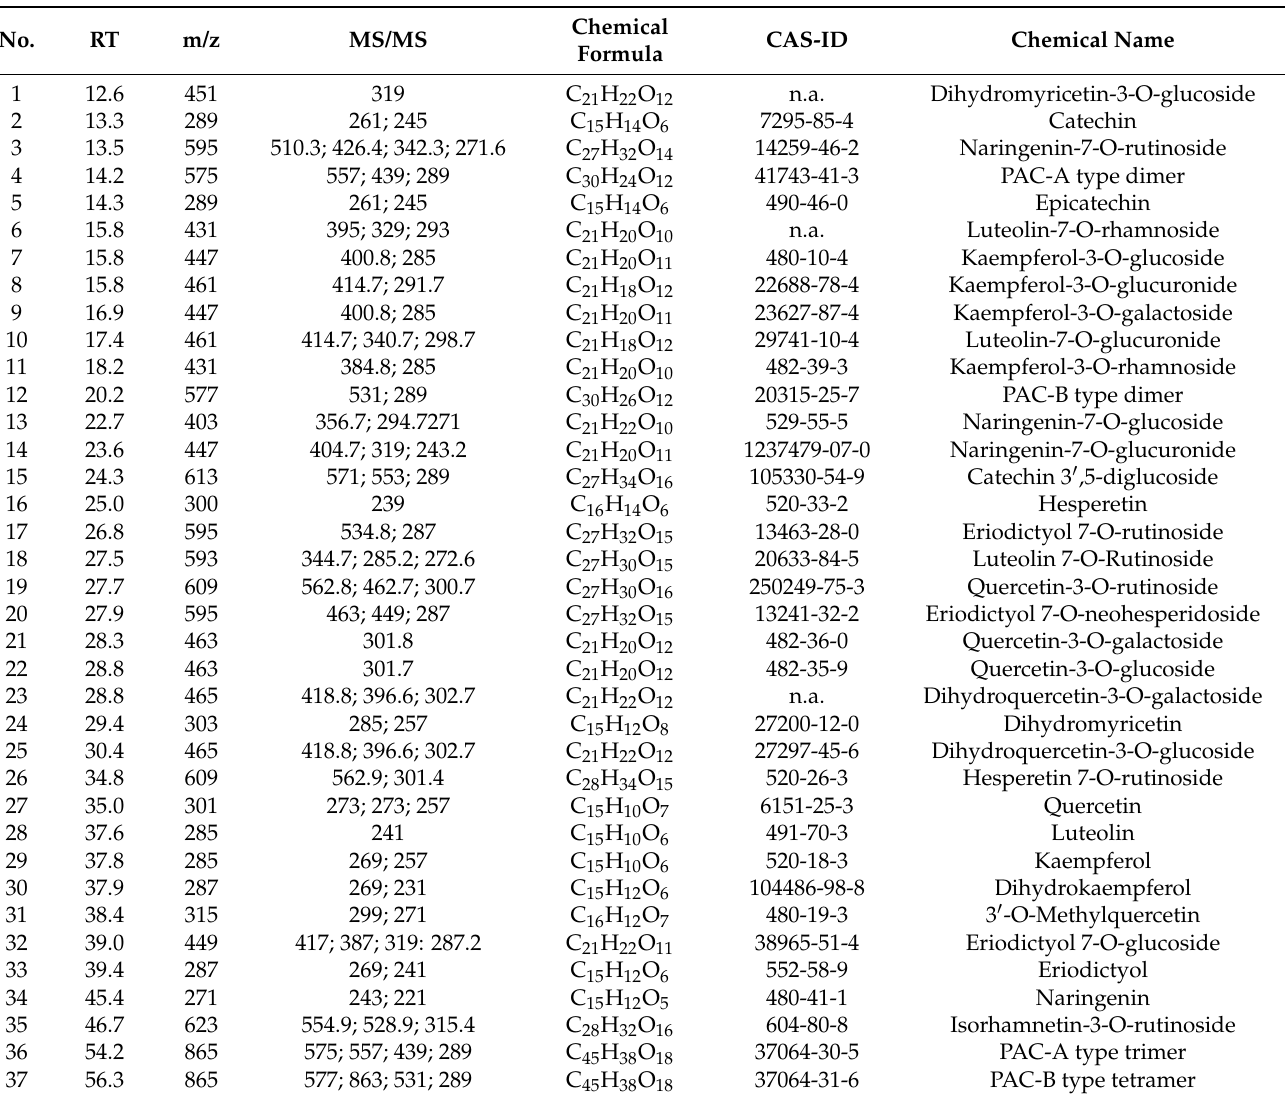
Table 1. Phenolic compounds identified and quantified in the pulp and peel of peach fruit samples. The table reports the retention time, mass-to-charge ratio, mass fragmentation pattern, chemical formula, international identification number and the name of the identified molecules. The number listed in the first column refers to the chemical structure of each molecule shown in Figure